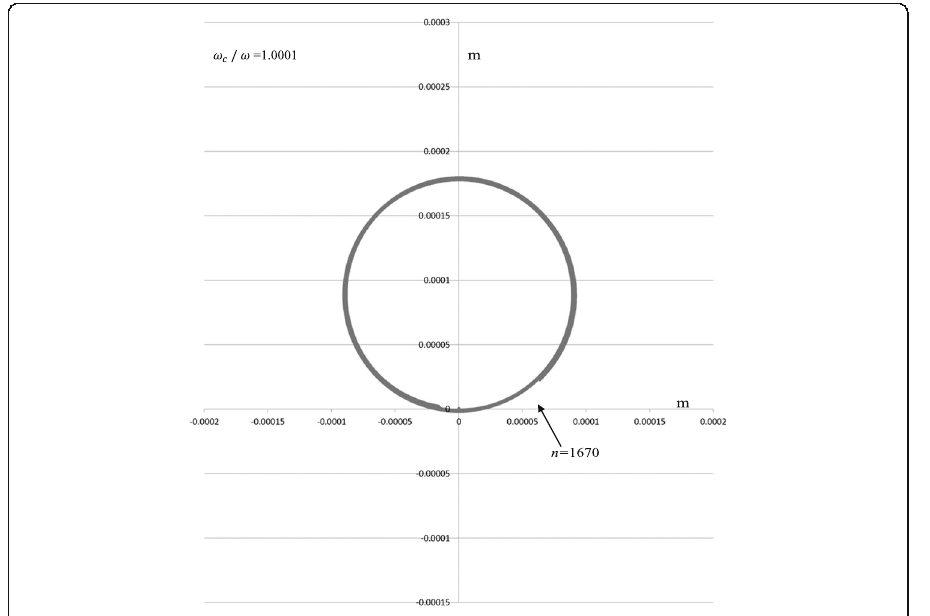
Fig. 12 The gyration orbit of a nonrelativistic electron. The physical conditions are the same with in Fig. 9, except for the following two changes: f